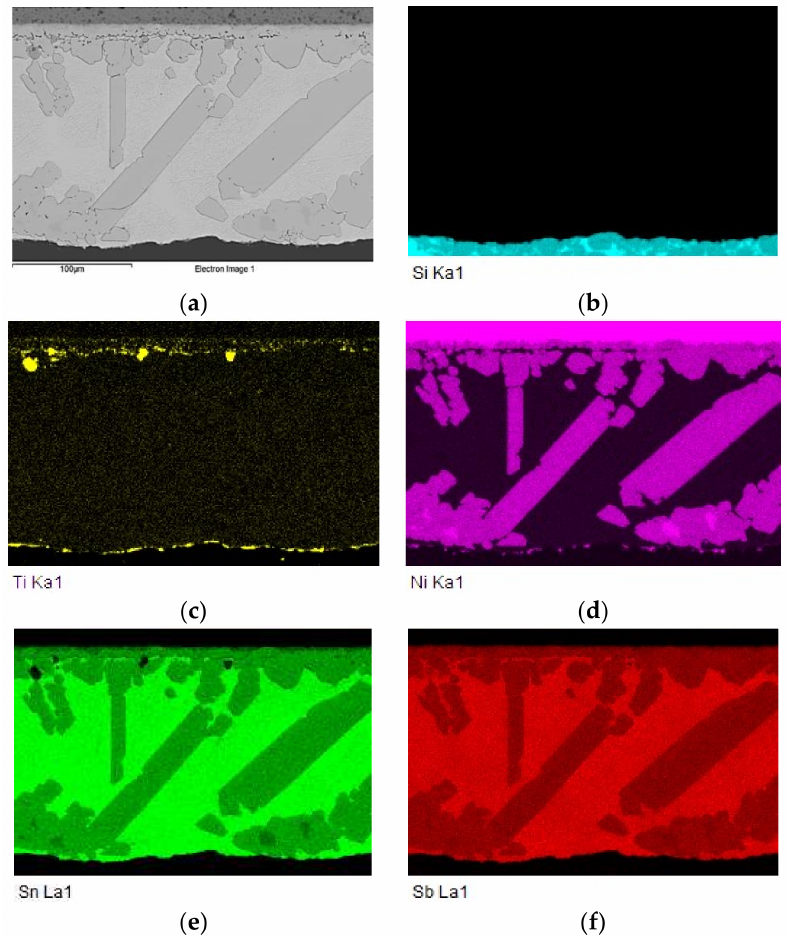
Figure 12. Planar distribution of Si, Ti, Ni, Sn and Sb elements on the boundary of SiC/Sn5Sb3Ti/Ni joint; ( a ) joint microstructure; ( b ) Si; ( c ) Ti; ( d ) Ni; ( e ) Sn; ( f )